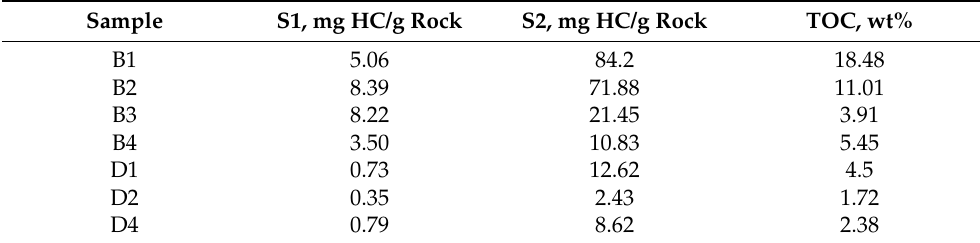
Table 3. Pyrolysis results of the Domanik and Bazhenov samples.